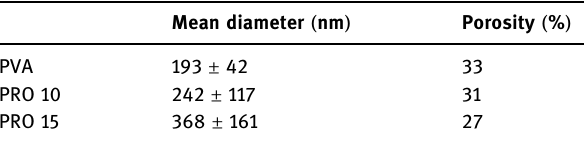
Table 1: Mean fi ber diameter and sca ff old porosity ratio Mean diameter ( nm